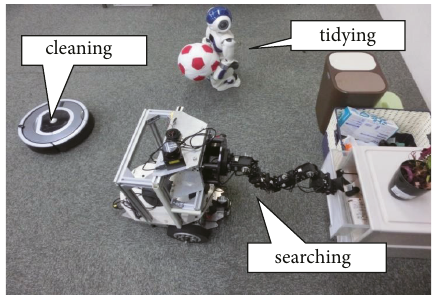
Figure 1: Task allocation to heterogeneous